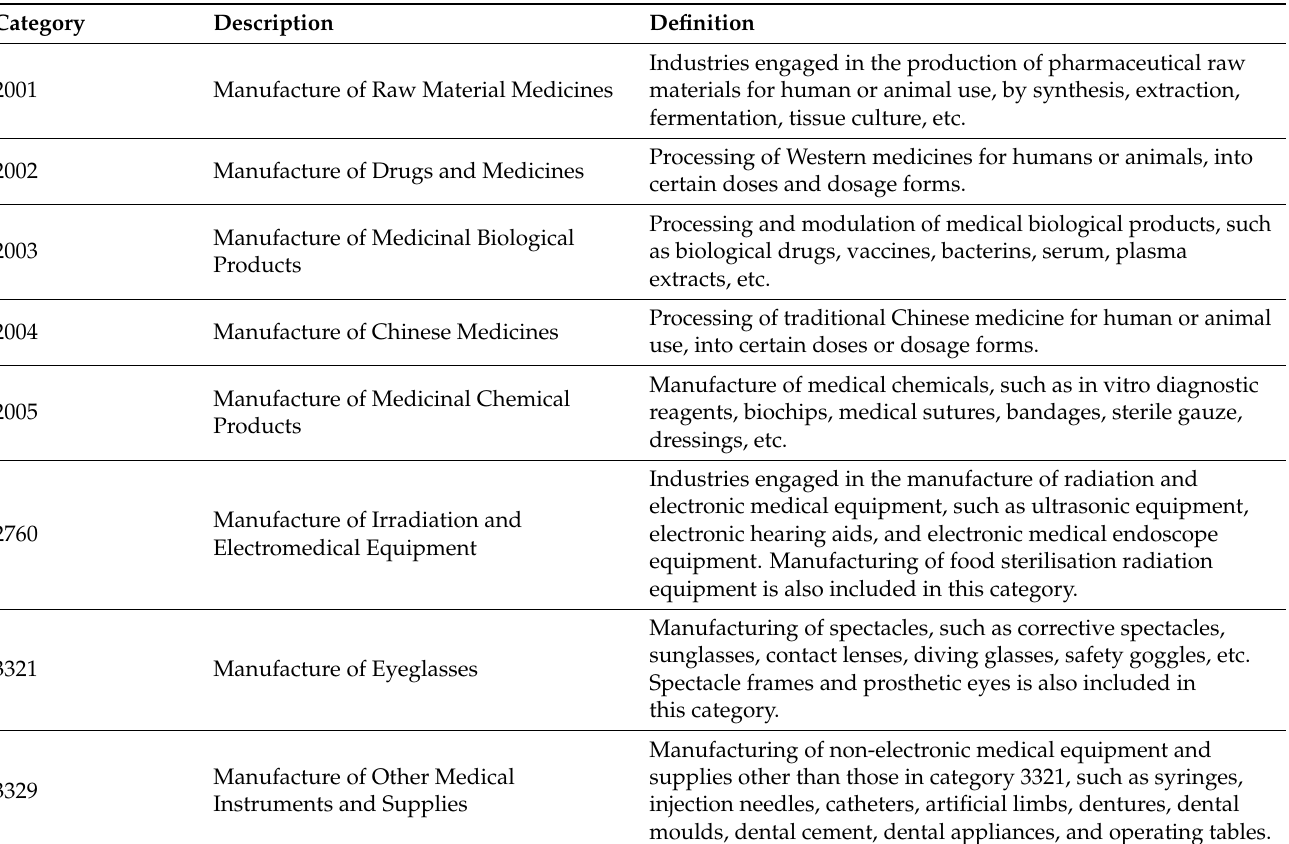
Table 1. Descriptions and definitions of eight different categories of the